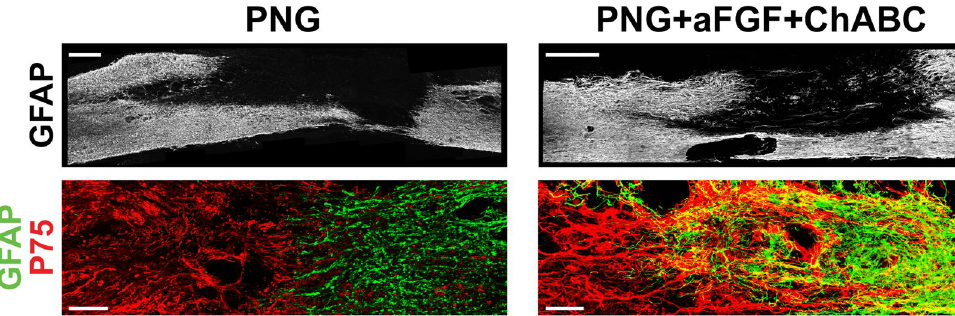
Figure 4. aFGF and ChABC promote astrocyte and Schwann cell integration at the interface of PNG and caudal spinal cord. Representative confocal images of sagittal sections showing PNG- (left column) or PNG + aFGF + ChABC- (right column) treated spinal cords 40 weeks post-injury. The top row shows low magnification of GFAP staining (white). Note the extensive migration of GFAP + astrocytes throughout the PNG (GFAP-negative area) only following PNG + aFGF + ChABC treatment. Scale bar, 500 µ m. Bottom row shows high magnification of PNG p75 + Schwann cells (red) and spinal cord GFAP + astrocytes (green). Note the migration and integration of Schwann cells and astrocytes, including overlapping spatial domains (yellow), only following PNG + aFGF + ChABC treatment. Scale bar, 100 µ